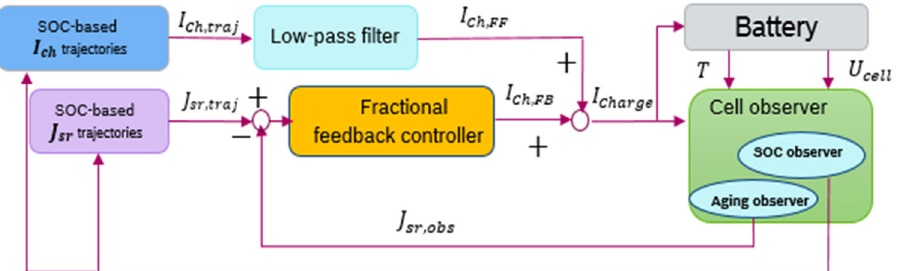
Figure 10. Modified charging controller.